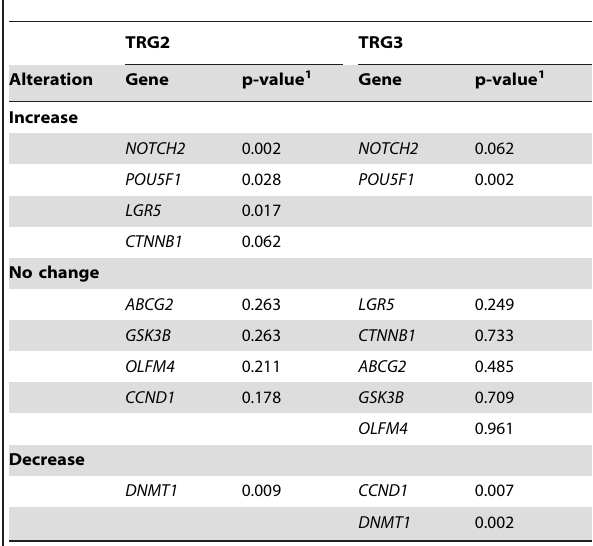
Table 5. Alterations of expression between pre- and post- therapeutic tumours of patients with tumour regression grade (TRG) 2 and 3.